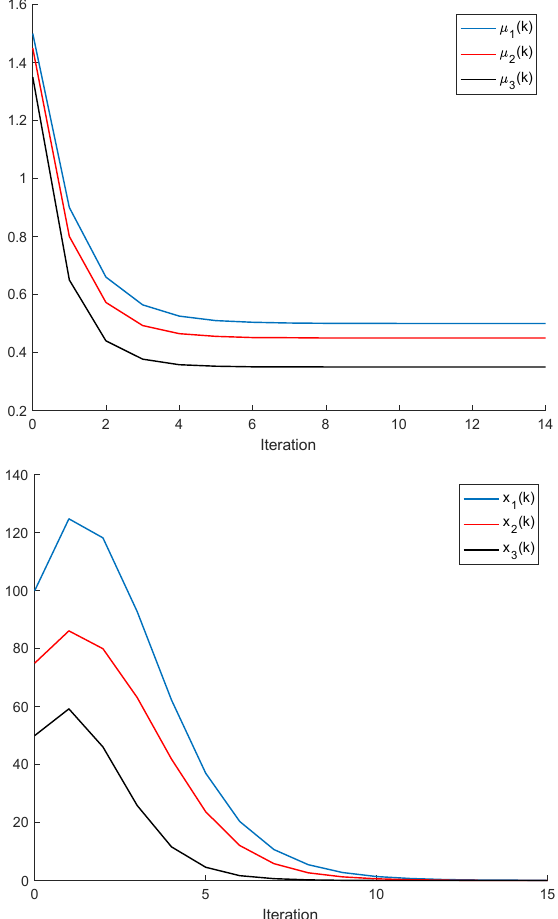
Figure 11. Evolution of x 1 ( k ), x 2 ( k ) and x 3 ( k ) for constant parameters in Example 7 when no harvesting quota nor external consumption are included and growth rates are smaller than unity.